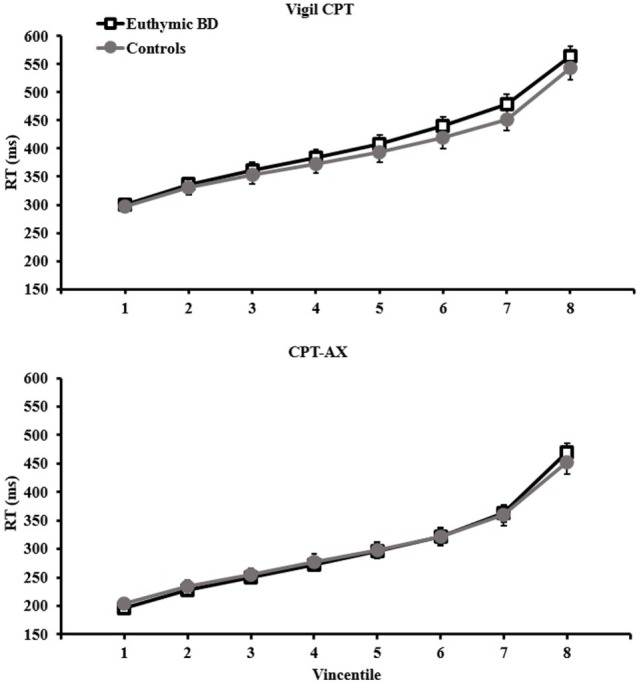
Vincentile plots (1–8) for euthymic BD (n = 22) and controls (n = 20) per task. Mean RTs are taken from the slowest 12.5% (1) to the fastest (8). Plots for Vigil CPT are represented in the top panel and CPT-AX in the bottom. Error bars represent SEM.